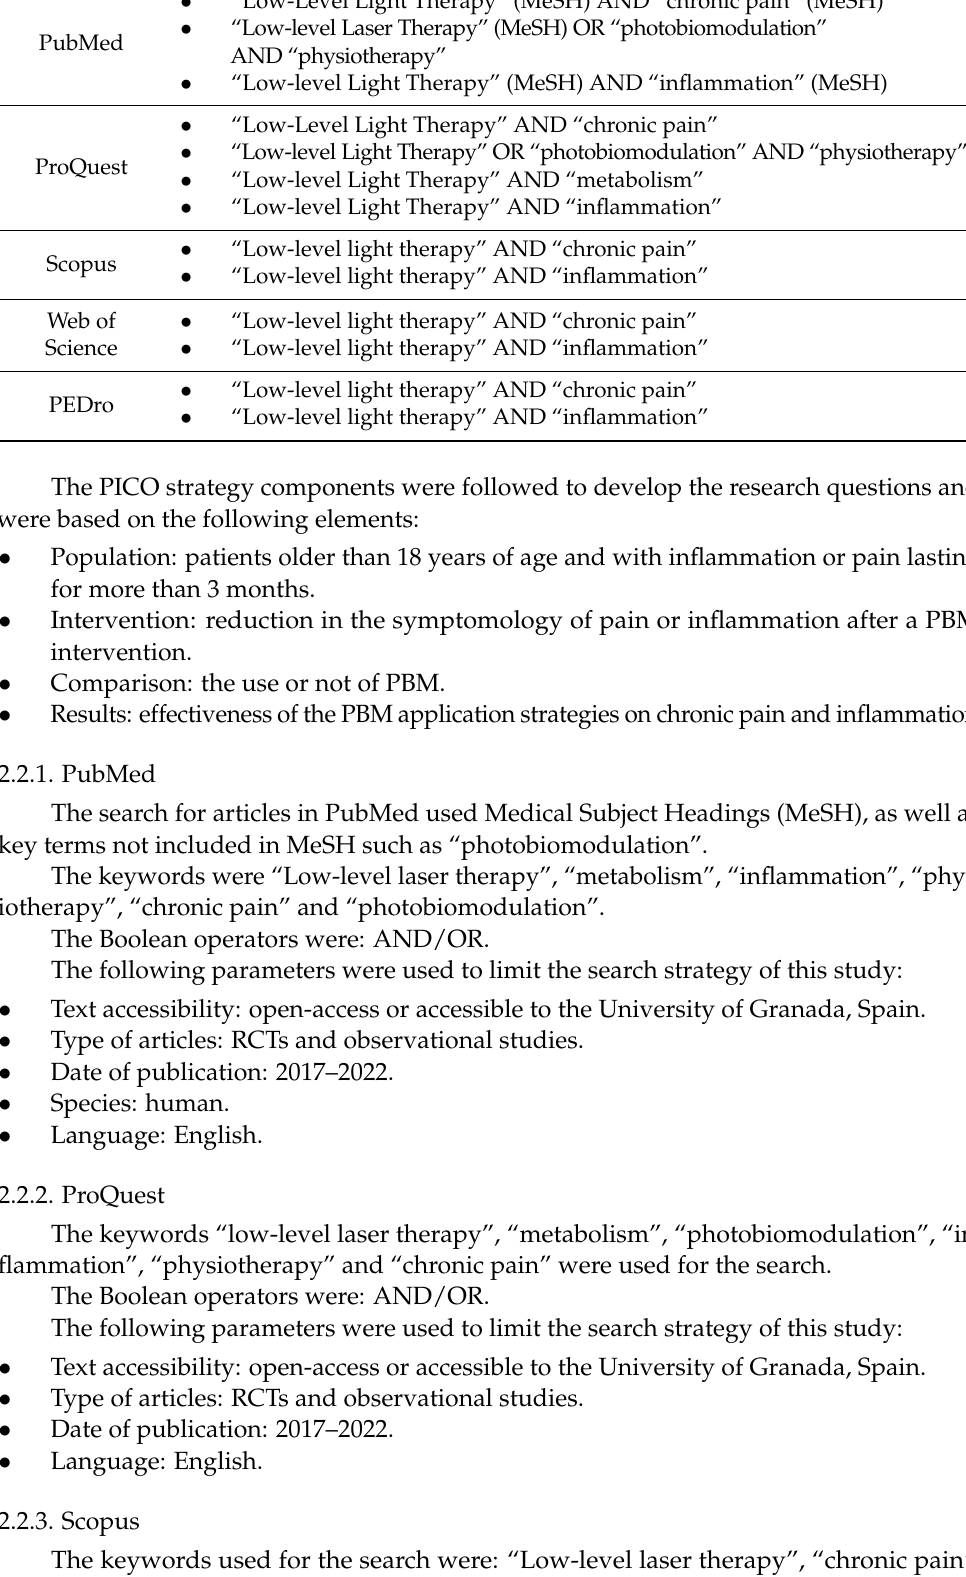
Table 1. Search strategy in the different databases used. • “Low-Level Light Therapy” (MeSH) AND “chronic pain” (MeSH) • “Low-level Laser Therapy” (MeSH) OR “photobiomodulation” PubMed AND “physiotherapy” • “Low-level Light Therapy” (MeSH) AND “inflammation” (MeSH) • “Low-Level Light Therapy” AND “chronic pain” • “Low-level Light Therapy” OR “photobiomodulation” AND “physiotherapy” ProQuest • “Low-level Light Therapy” AND “metabolism” • “Low-level Light Therapy” AND “inflammation” • “Low-level light therapy” AND “chronic pain” Scopus • “Low-level light therapy” AND “inflammation” Web of “Low-level light therapy” AND “chronic pain” Science “Low-level light therapy” AND “inflammation”